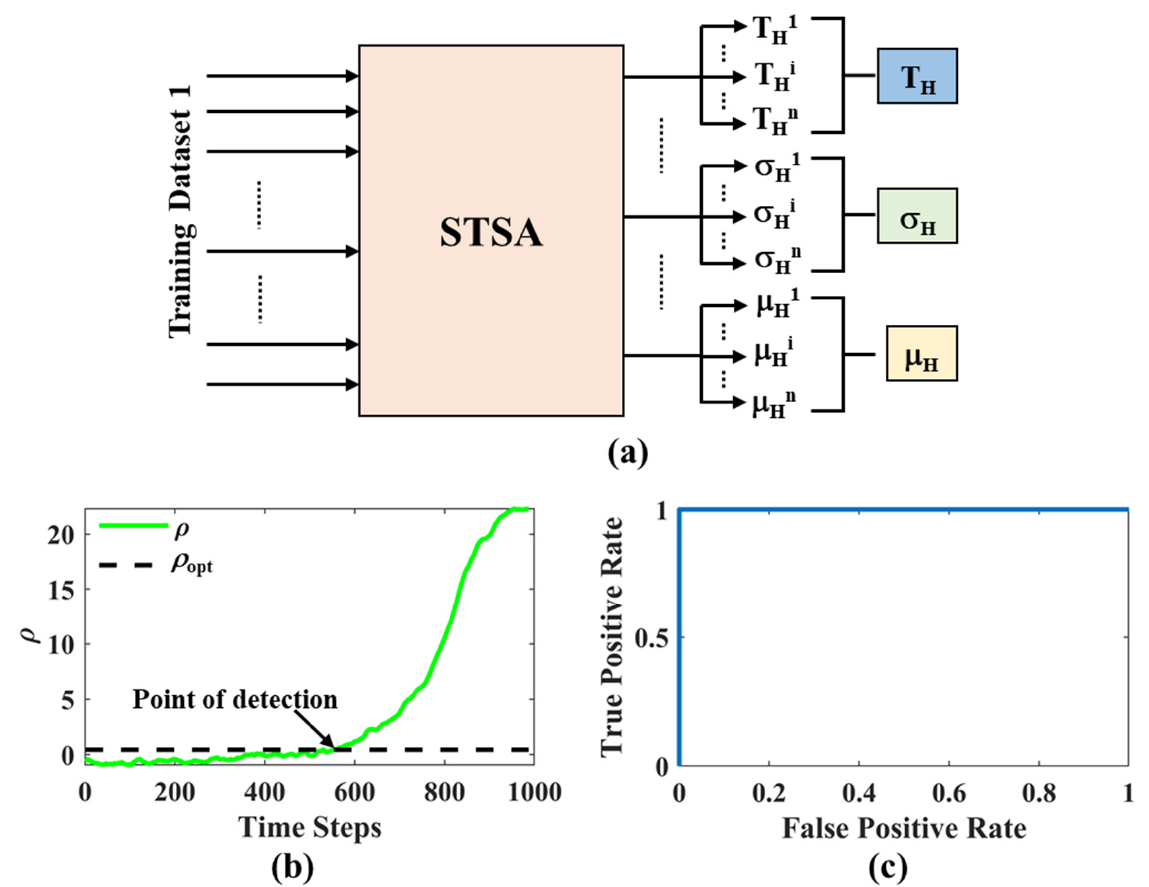
Figure 7. ( a ) Framework for training the healthy features ( T H , σ H , and µ H ) using STSA; ( b ) A typical nature of ρ as observed through the analysis (for representative purposes) indicating the optimal threshold ( ρ opt ); ( c ) The corresponding ROC curve.